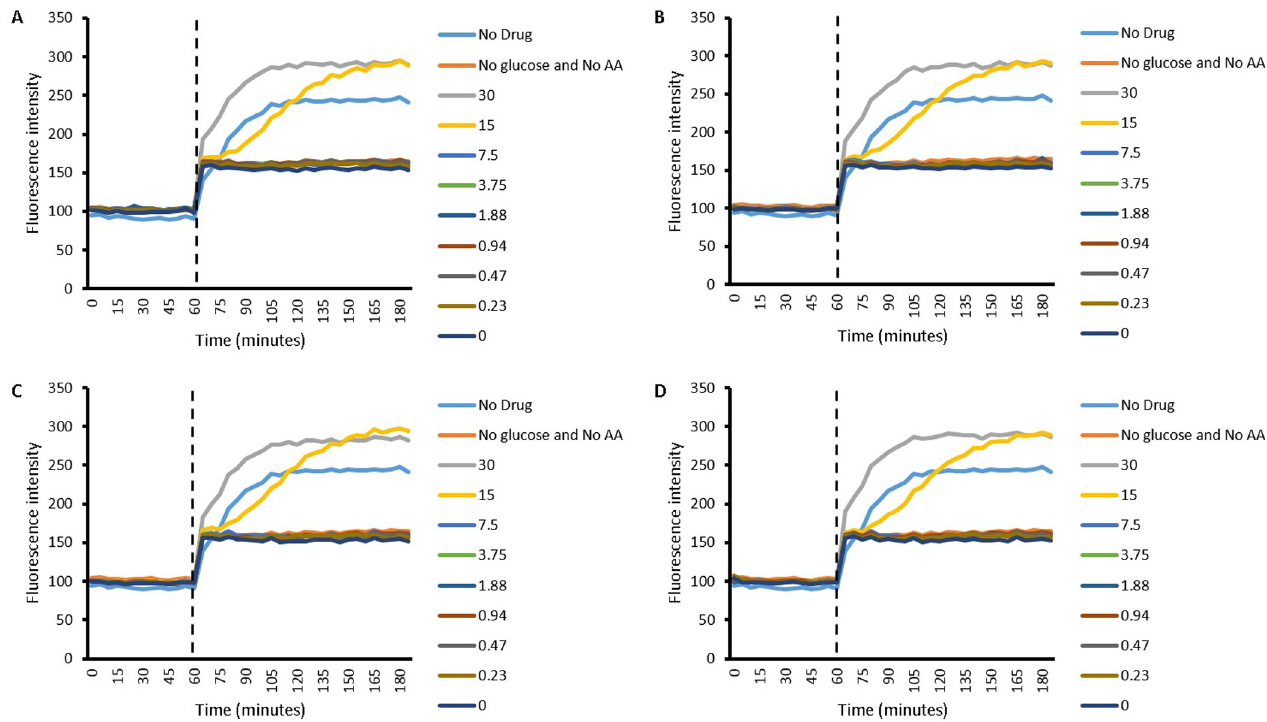
Fig 6. Efflux of EtBr by P . aeruginosa in the presence of different concentrations of L-Glu (30 mM to 0.23 mM). A) 1.06 μ M Cip B) 0.53 μ M Cip C) 0.27 μ M Cip D) 0.13 μ M Cip. In the legend, numbers 0 to 30 represent amino acid concentrations in combination with respective Cip concentration.Firstly, the dashed line represents end of the first part of experiment where Cip and EtBr was allowed to accumulate within energy deprived cells and secondly the start of accumulation in the presence of the amino acid, with or without energy; n = 4.